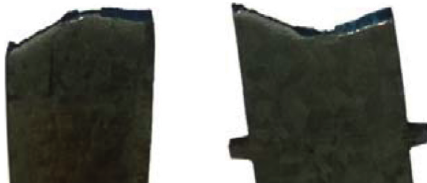
Figure 11: Blue brittle phenomenon for steel plates. Table 4: Average percentage elongation after fracture (cooled down).